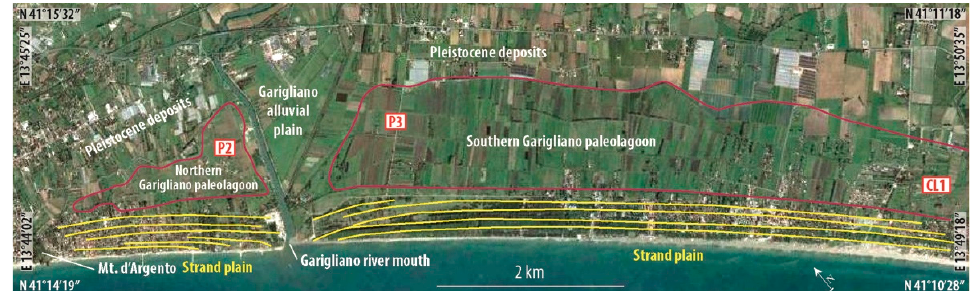
Figure 9. Morphological scheme of the Campania area. The yellow lines indicate the trend of the Holocene beach/dune ridges. The red line indicates the outline of the marshes/ponds, today reclaimed. The labels in the white rectangles indicate the location of the boreholes, shown in Figure 10 (Image Landsat/Copernicus—Google Earth).